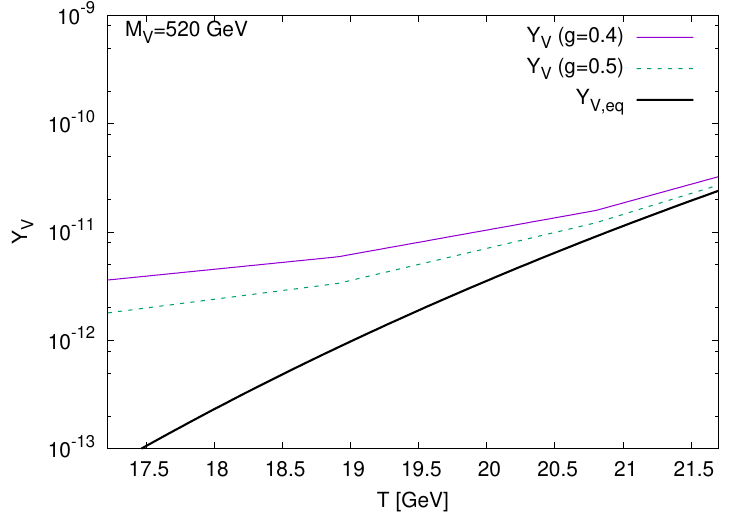
Figure 1 . Evolution of Y V and Y V; eq during the epoch of DM chemical decoupling (freeze-out).